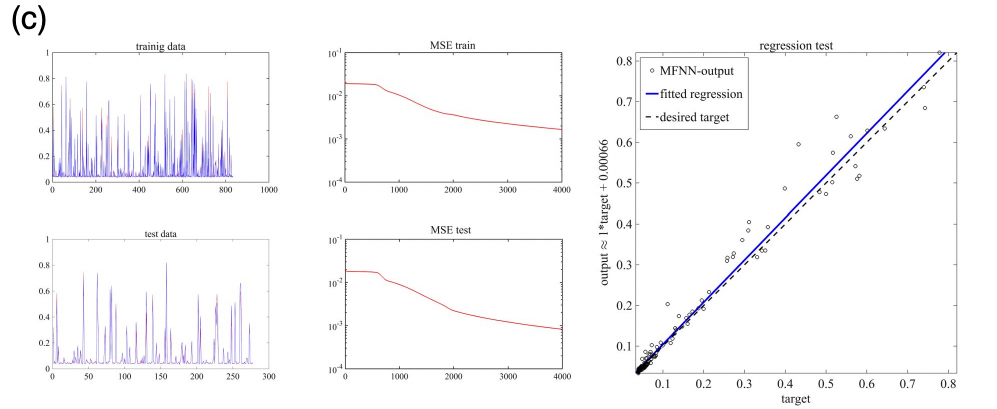
Figure 9. The performance of MFNNs algorithm for Case1 ( a ), Case2 ( b ), and Case3 ( c ). In the first column, the desired trajectories (shown in blue) are compared with the MFNN output (shown in red). In the second column, we have the relative MSE, and the regression test is given in the third column.